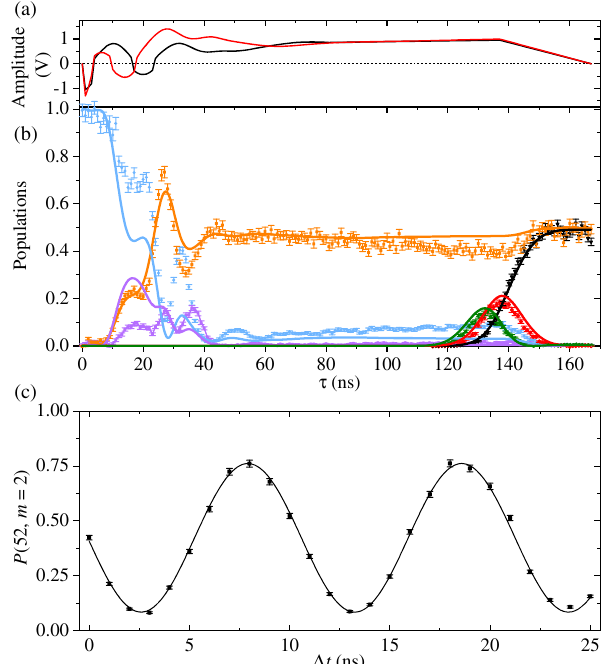
FIG. 8. Cat state preparation with the optimized pulse. (a) Con- trol voltages V r ð τ Þ (black line) and V i ð τ Þ (red line), applied to produce the superposition of 52 m 1 and 52 c , as a function of time. (b) Time evolution of the population P j ð τ Þ of level j ( j ¼ m 1 , m 2 , m e e c ). The points are experimental with statistical 3 , 2 , 1 , and error bars, using the color code of Fig. 1. The solid lines correspond to the theoretical prediction for the optimized pulse. The final target state population (averaged over the last six points) is P c ¼ 48 ð 1 Þ % and P m ¼ 48 . 4 ð 8 Þ % . (c) Probability to find the 1 atoms in the 52 m 2 state after the pulse (a) followed by the time-reversed optimized pulse that recombines 52 m 1 and 52 c (Appendix F) as a function of the delay Δ t between the pulses. The points are experimental with statistical error bars, the solid line is a sine fit. The large fringe visibility, mostly limited by